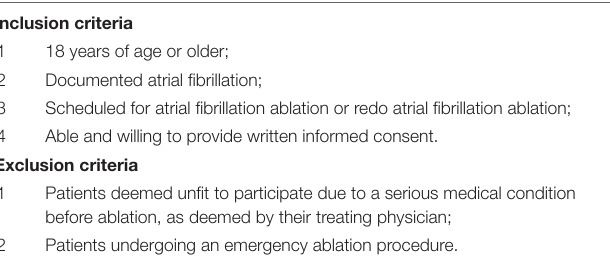
TABLE 1 | In- and exclusion criteria of the ISOLATION